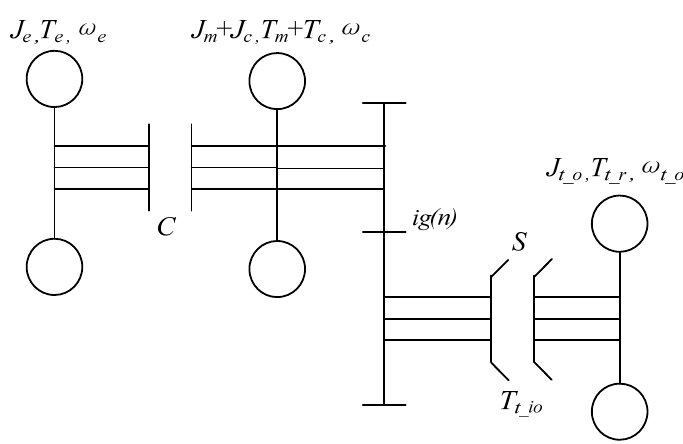
Figure 2. Dynamic model for AMT shifting without a